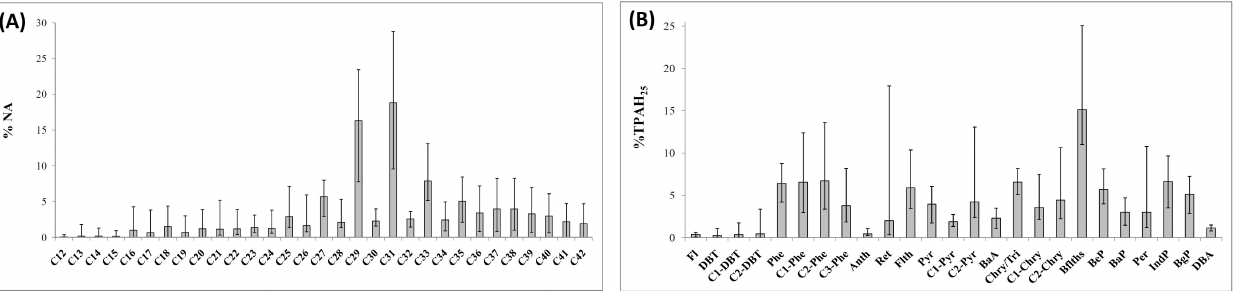
Fig. 2. Molecular profile of n -alkanes (A) and PAHs (B) in deep-sea sediments of the study area. Individual compound abundances are normalized as percentage of the total sum of NA or PAHs (TPAH 25 ) , respectively, and presented along withmin–max deviation lines. NA homologues are assigned with their number of carbon atoms. PAH abbreviations: fluorene (Fl), dibenzothiophene (DBT), methyldibenzoth- iophenes (C 1 -DBT), dimethyldibenzothiophenes (C 2 -DBT), phenanthrene (Phe), methylphenanthrenes (C 1 -Phe), dimethylphenanthrenes (C 2 -Phe), trimethylphenanthrenes (C 3 -Phe), anthracene (Anth), fluoranthene (Flth), pyrene (Pyr), methylpyrenes (C 1 -Pyr), dimethylpyrenes (C 2 -Pyr), retene (Ret), benz[ a ]anthracene (BaA), chrysene/triphenylene (Chry/Tri), methylchrysenes (C 1 -Chry), dimethylchrysenes (C 2 - Chry), benzo[ b/j/k ]fluoranthenes (BFlths), benzo[ e ]pyrene (BeP), benzo[ a ]pyrene (BaP), perylene (Per), indeno[1,2,3- cd ]pyrene (IndP),